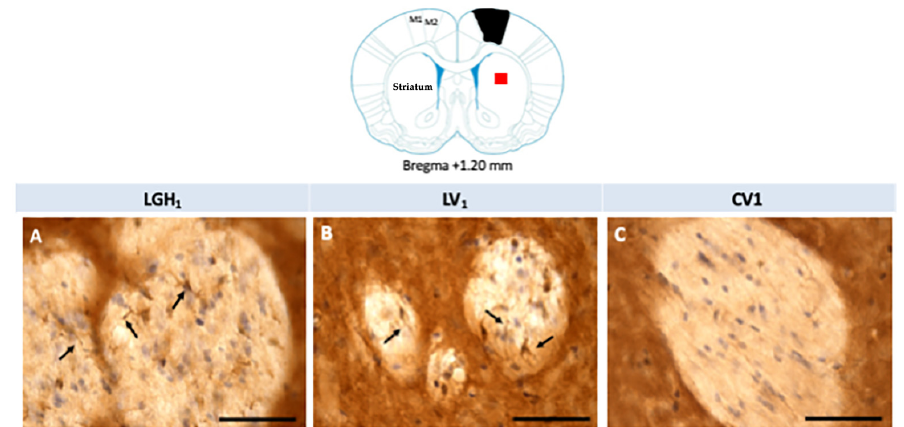
Figure 7. Nestin expression in the ventral thalamic nucleus, ipsilateral to the lesion, of animals belonging to the three experimental groups (LGH1, LV1 and CV1), sacrificed at 25 dpi. ( A ) Nestin-ir fibers in the ventral thalamic nucleus of a rat treated with GH immediately after the lesion can be seen. ( B ) A similar nestin immunolabeling can be seen in a rat treated with vehicle immediately after the injury was produced. ( C ) In sham-operated animals, the expression of nestin is restricted to blood vessels. The arrows point to the microglia prolongations. ( D ) Mean nestin reaction intensity of gray level variation expressed in arbitrary units (AU); values represent mean + SEM, n = 2. No differences were found in the intensity of nestin reaction. Coronal sections at − 2.04 mm from Bregma. The red square shows where the upper photomicrographs correspond. Scale bar: 50 µm.